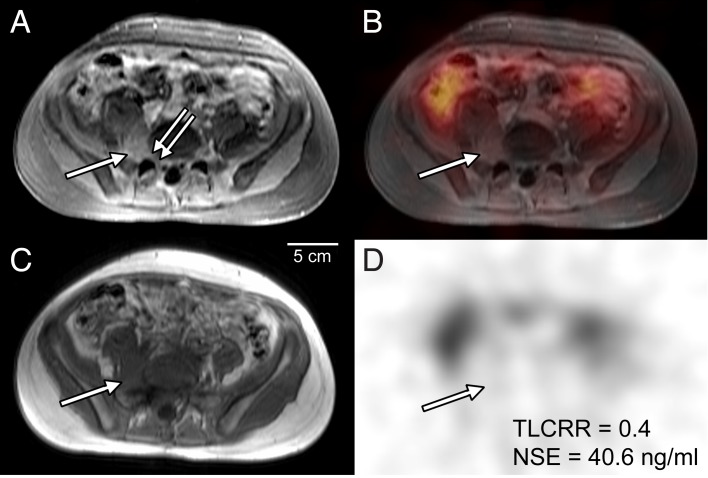
True positive prediction of unfavorable histopathology (UH) by combined TLCRR/NSE criteria in a 14 year old boy.T1-weighted axial MRI with (A) and without (C) contrast enhancement, 123I-MIBG SPECT (D) and fused SPECT/MRI (B) of the lower abdomen are shown. Tumor is depicted as contrast enhancing lesion in a paravertebral location (A, arrow) with infiltration of the L5 neuroforamen (A, double arrow). Tumor-to-liver count-rate ratio (TLCRR) was < 2.0 (D, false negative). Serum neuron-specific enolase (NSE) level was > 25.8 ng/ml (D, true positive). Combined analysis resulted in a true positive finding for UH. Undifferentiated neuroblastoma was confirmed by histopathology following surgery.